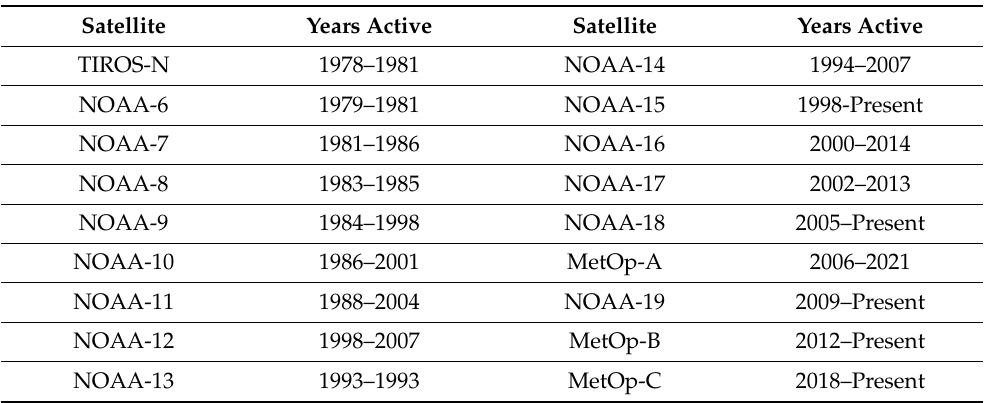
Table 1. Satellites equipped with the AVHRR sensor. The most recent NOAA polar orbiting satellites, NOAA-20 (launched 2017) and NOAA-21 (launched 2022), replaced the AVHRR with the Visible Infrared Imaging Radiometer Suite developed from the Moderate Resolution Imaging Spectrora- diometer flown on the Aqua and Terra